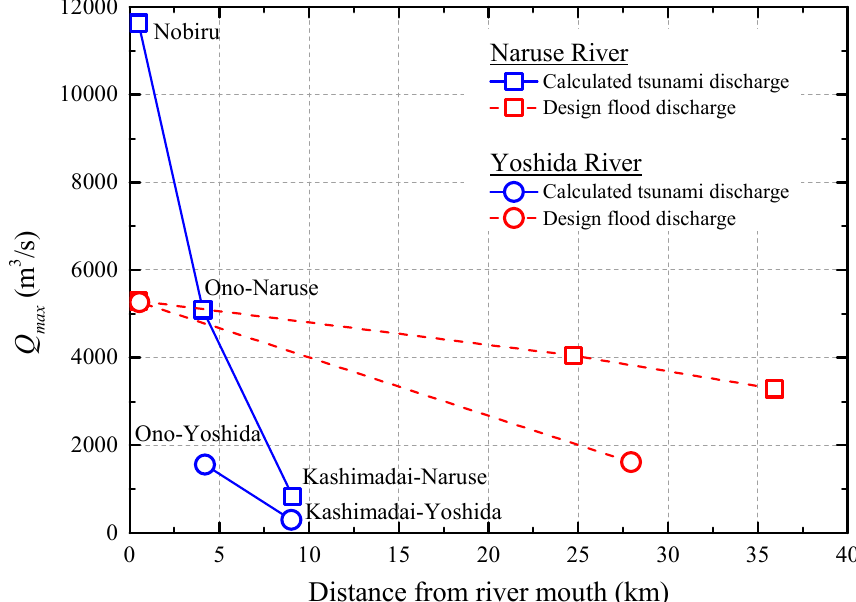
Figure 12. Comparison of maximum discharge induced by tsunami and design flood discharge of Naruse and Yoshida Rivers.